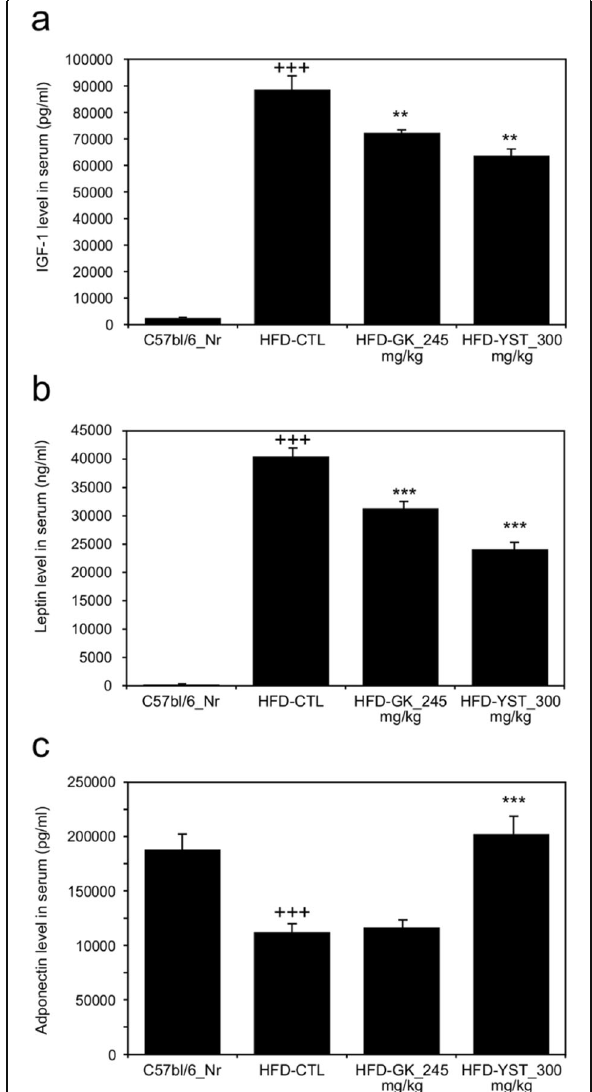
Fig. 3 Effects of YST extract on the serum IGF-1, leptin, and adiponectin levels in high-fat diet (HFD)-fed mice, where ( a ) IGF-1, ( b ) leptin, and ( c ) adiponectin. Normal diet group: C57bl/6J-Nr; HFD-control group: HFD- CTL; HFD plus 245mg/kg Garcinia cambogia extract: HFD-GK; HFD plus 300mg/kg YST: HFD-YST. The results are expressed as mean±SEM ( n = 6). + p <0.05, ++ p <0.01, and +++ p <0.001 compared with C57bl/6J-Nr, and * p <0.05, ** p <0.01, and *** p <0.001 compared with